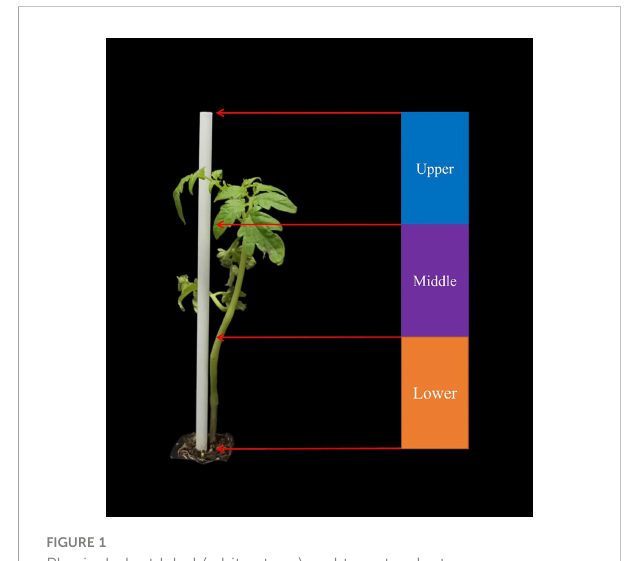
FIGURE 1 Physical plant label (white straw) and tomato plant.